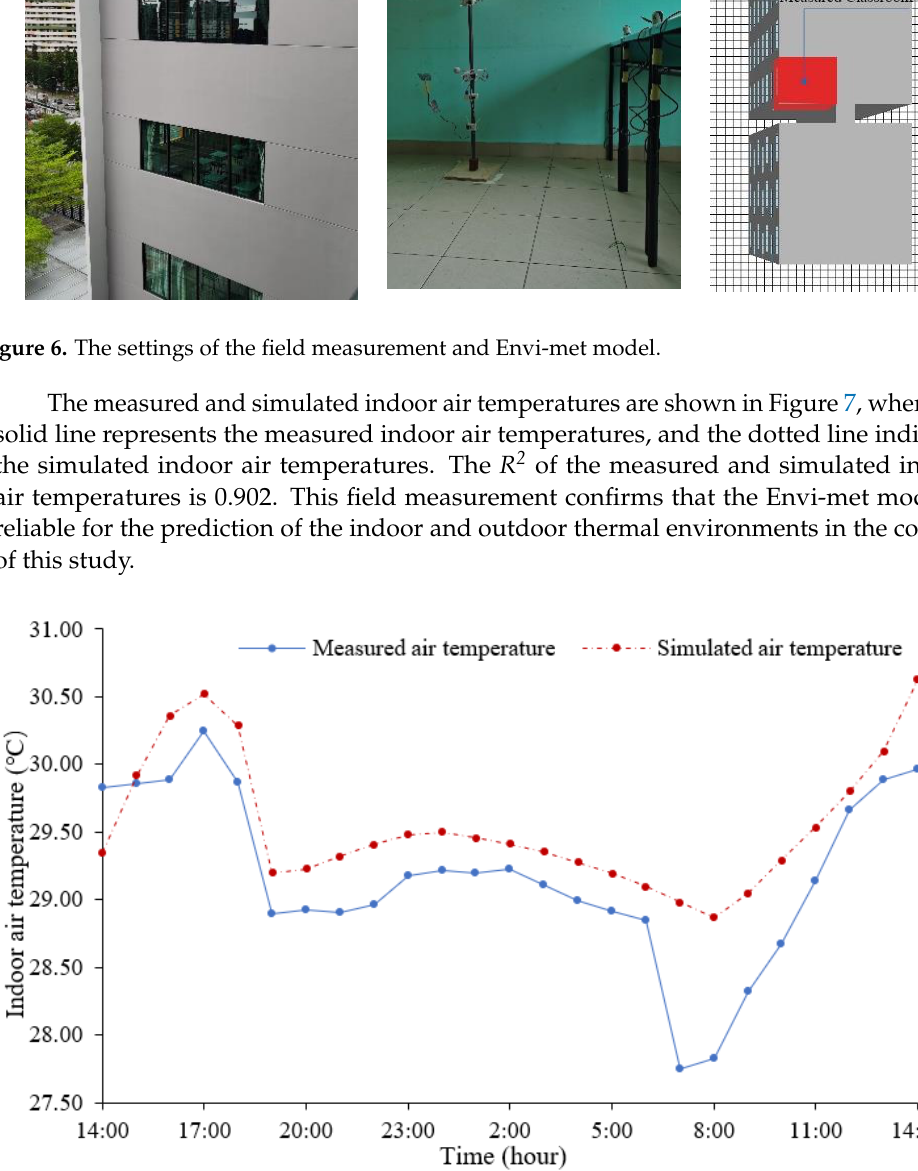
Figure 7. The measured and simulated indoor air temperatures.